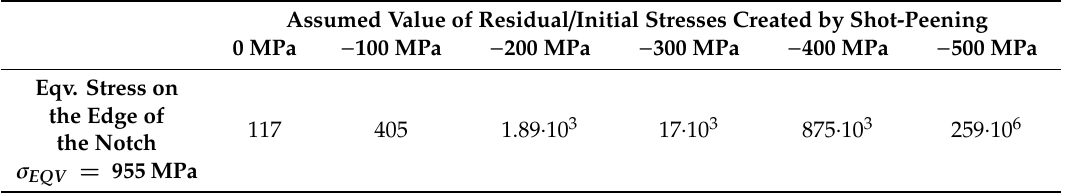
Table 2. Results of the numerical fatigue analysis based on the maximum value of the equivalent stress, with amplitude of resonance vibrations of 1.8